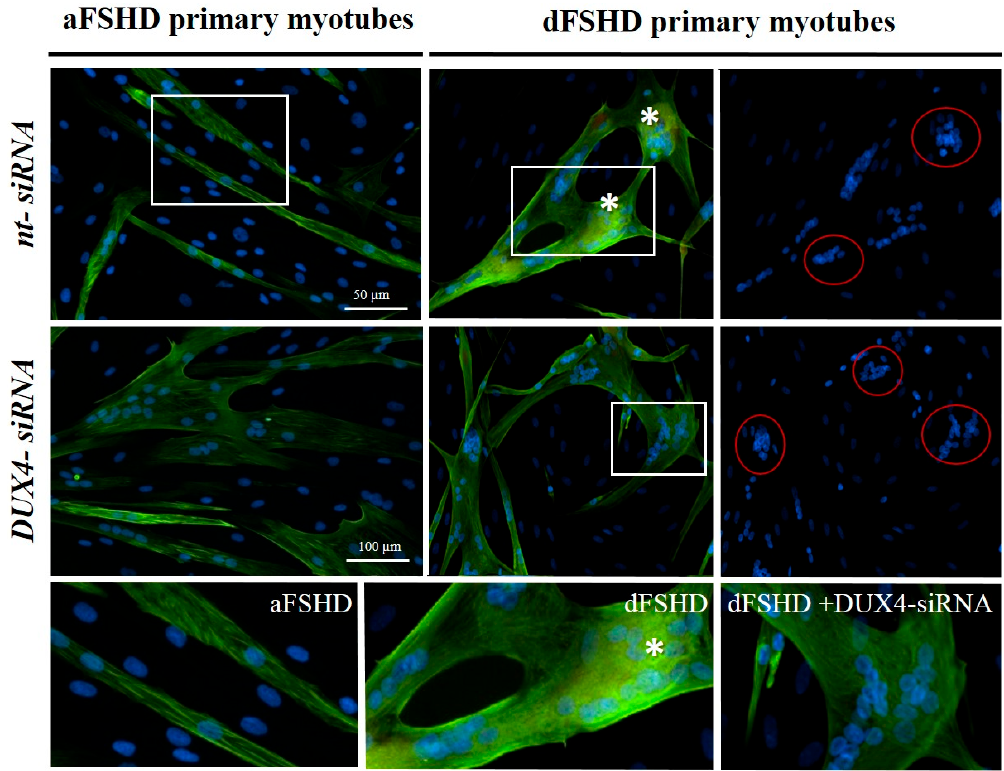
Figure 4. DUX4 inhibition prevents the formation of atrophic, but not disorganized FSHD myotubes. aFSHD and dFSHD primary myoblasts were transfected with either DUX4 siRNA or a non-targeted (nt) siRNA as indicated and switched to differentiation medium. Eight days later, the myotube morphology was highlighted through immunofluorescence staining of troponin T (green) and nuclei with DAPI (blue). Bottom panels: Magnified boxed regions. Stars indicate the accumulation of troponin T near clusters of nuclei. Scale bars: 50 μ m.